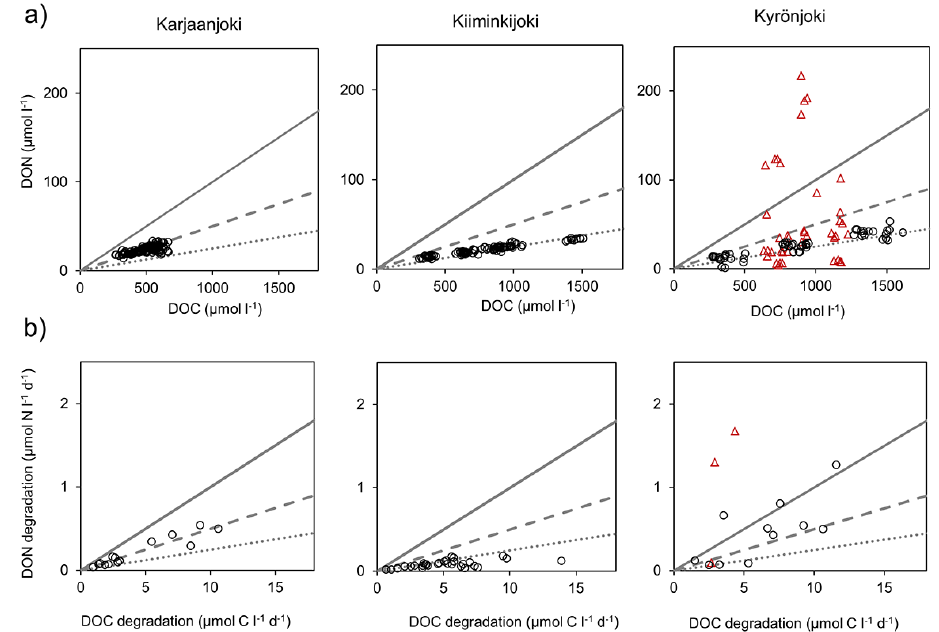
Fig. 4. Relationships between (a) DOC and DON concentrations in experiment units, and (b) daily degradation rate of DOC and DON in study estuaries. Lines denote fixed C:N relationships: solid line = 10, dashed line = 20 and dotted line = 40. In the Kyrönjoki graph (a) , the spring values are separated from other seasons as most of them deviate significantly from the average DOC:DON ratio of 40 measured in other seasons in Kyrönjoki. This spring subset is differentiated from the other data with red triangles. For each (a) figure, whole experiment data was used, and for each (b) figure, only differences between start and end were